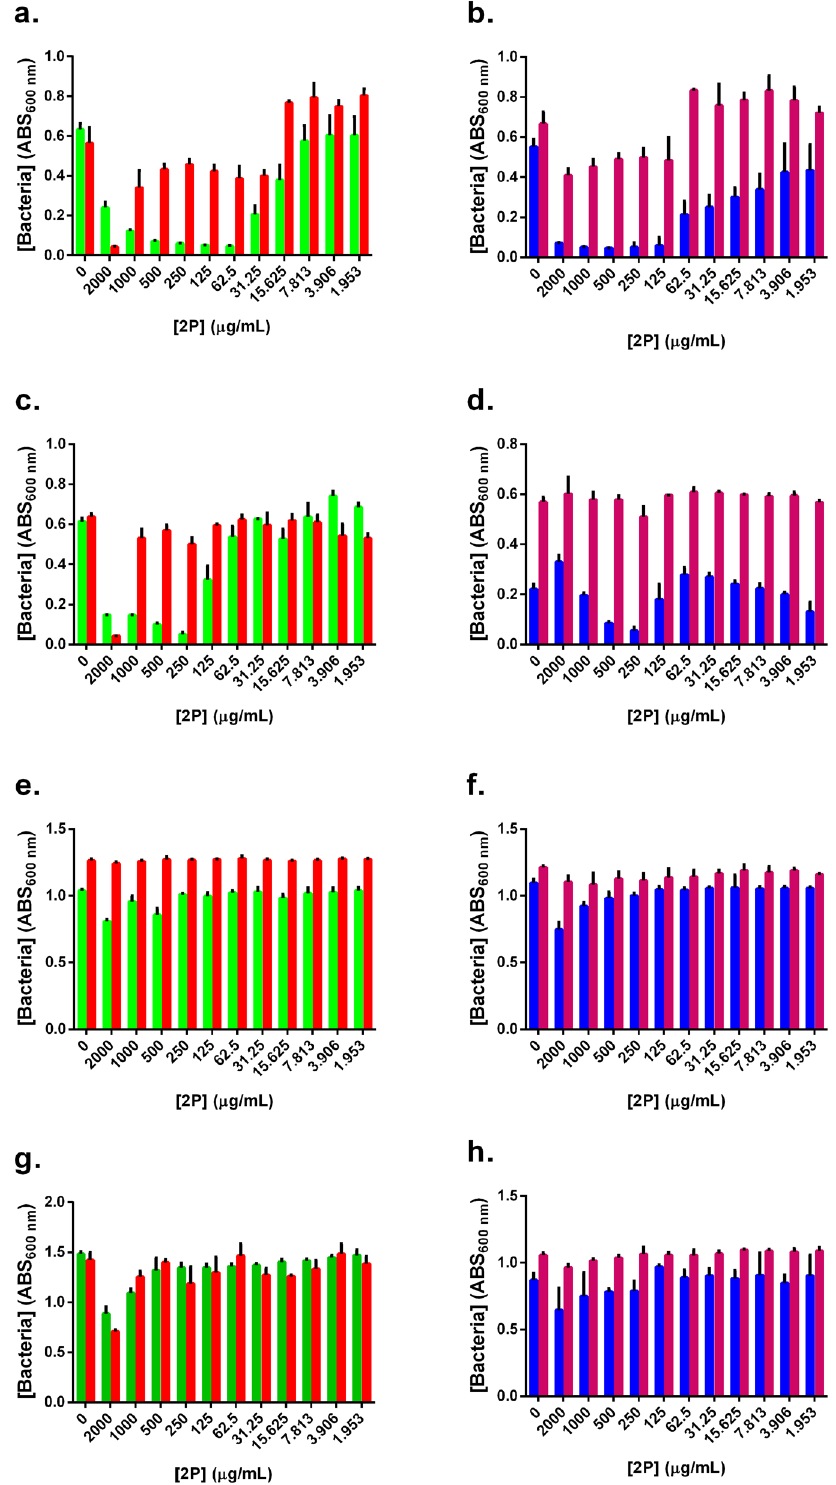
Figure 4. Minimal inhibitory concentrations (MICs, green) and minimal bactericidal concentrations (MBCs, red) ( a , c , e , g ), as well as minimal biofilm inhibitory concentrations (MBICs, blue) and minimal biofilm eradication concentrations (MBECs, magenta) ( b , d , f , h ) of 2P against S. aureus ( a , b ), E. faecalis ( c , d ), E. coli ( e , f ), and P. aeruginosa ( g , h ). Bars represent the interquartile range. ABS